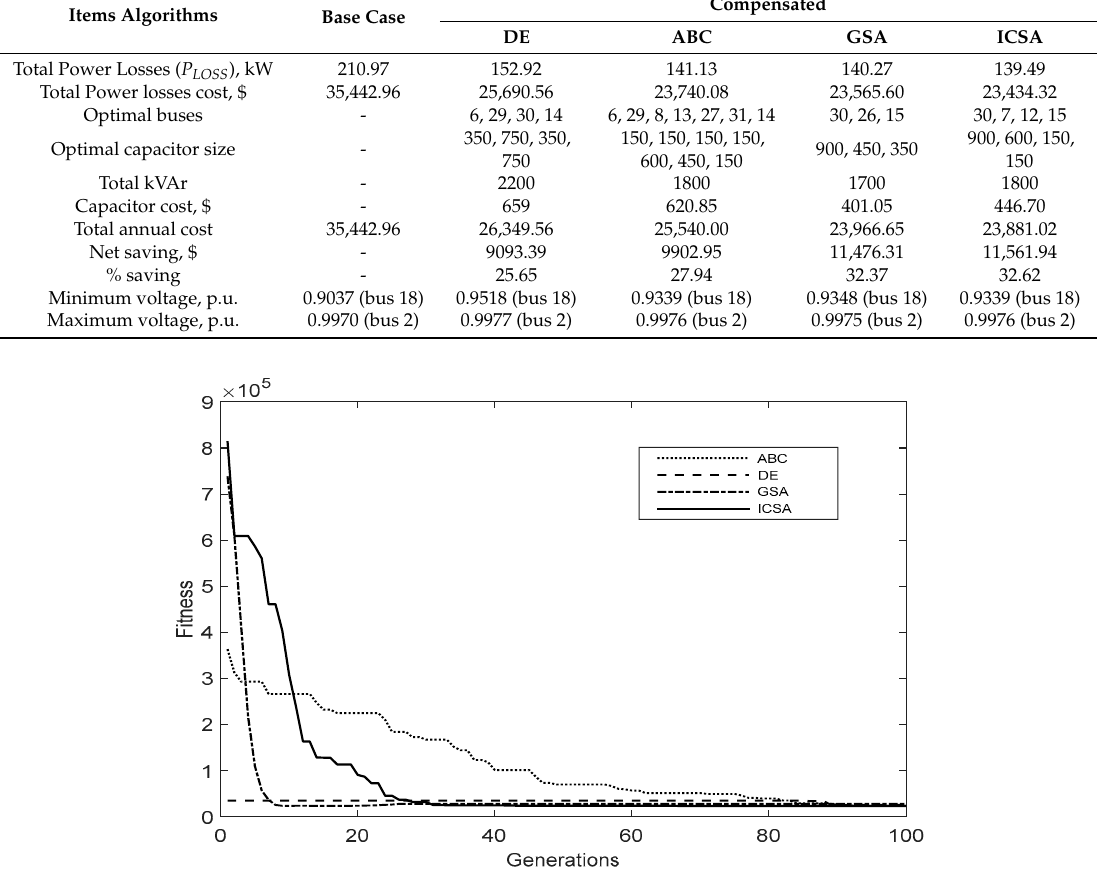
Figure 10. Convergence comparison 33-bus.